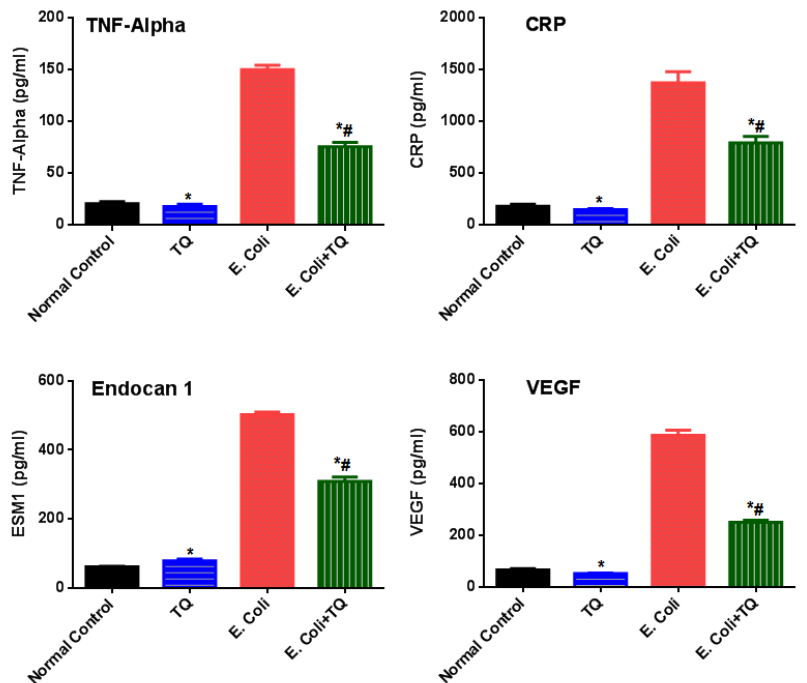
Figure 2. TNF- α , CRP, Endocan-1, VEGF levels in E. coli -induced sepsis measured six hours after bacterial challenge in mice treated with thymoquinone (TQ; n = 10 mice per group; data is given as mean ± SEM). * ( p < 0.05) in comparison with Normal Control; # ( p < 0.05) in comparison with E. coli.